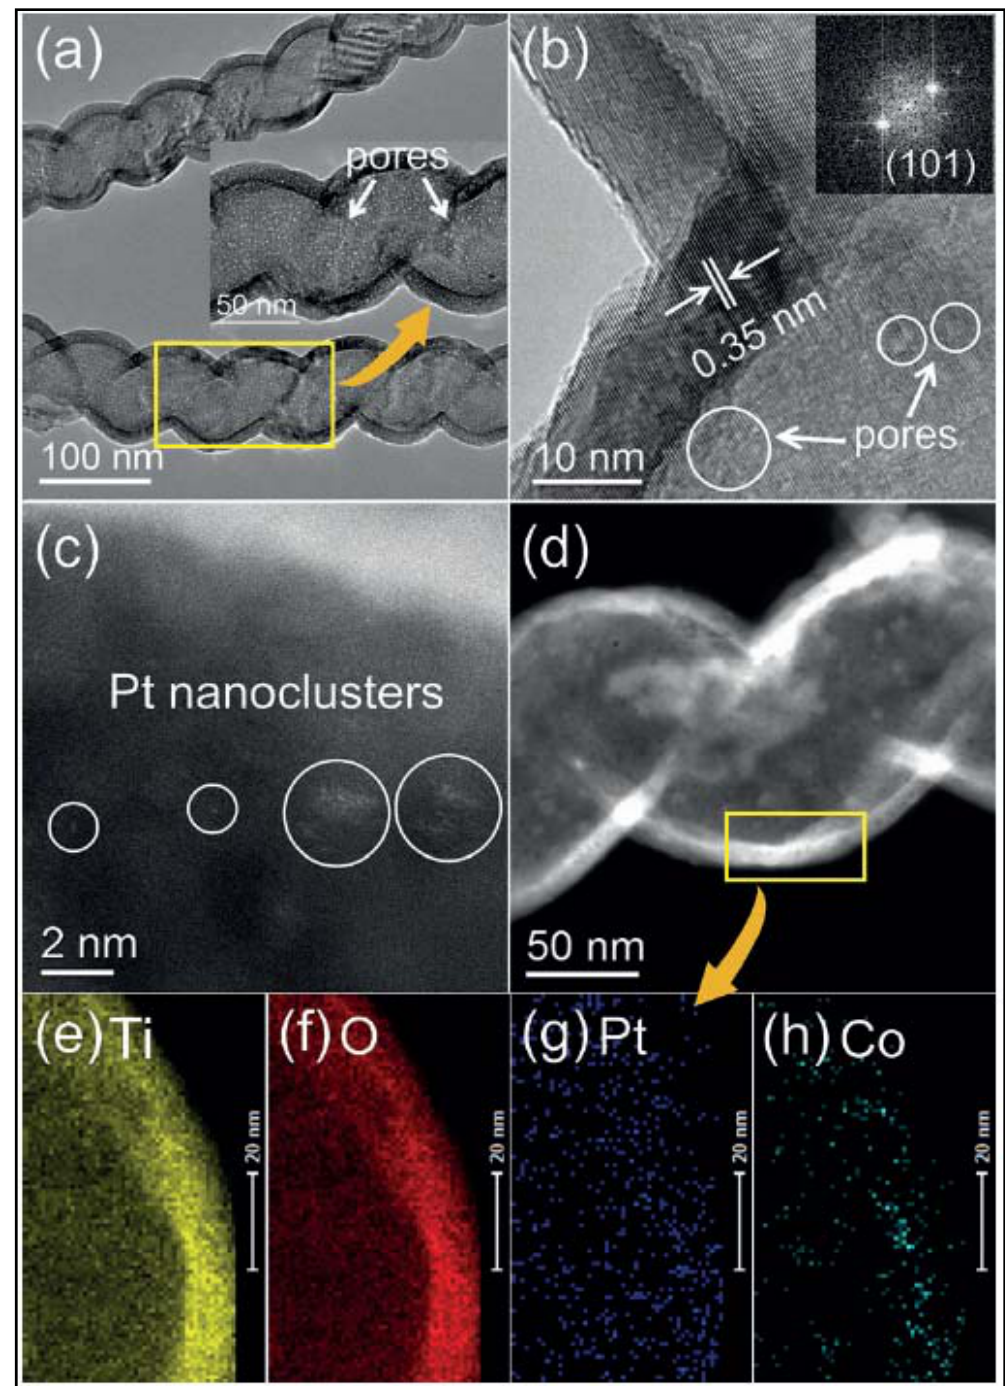
Figure 26. ( a ) TEM and ( b ) HRTEM images of the CoOx/TiO 2 /Pt samples (inset in ( a ), expanded view of the rectangular area; inset in ( b ), fast Fourier transform (FFT) of crystalized TiO 2 film). ( c ) Atomic-resolution HAADF-STEM image of the CoOx/TiO 2 /Pt samples. ( d – h ) STEM image and EDS mapping profiles of the rectangular area in panel ( d ) for ( e ) titanium, ( f ) oxygen, ( g ) platinum, and ( h ) cobalt. One ALD cycle for Pt and CoOx. Reproduced with permission from reference [143].